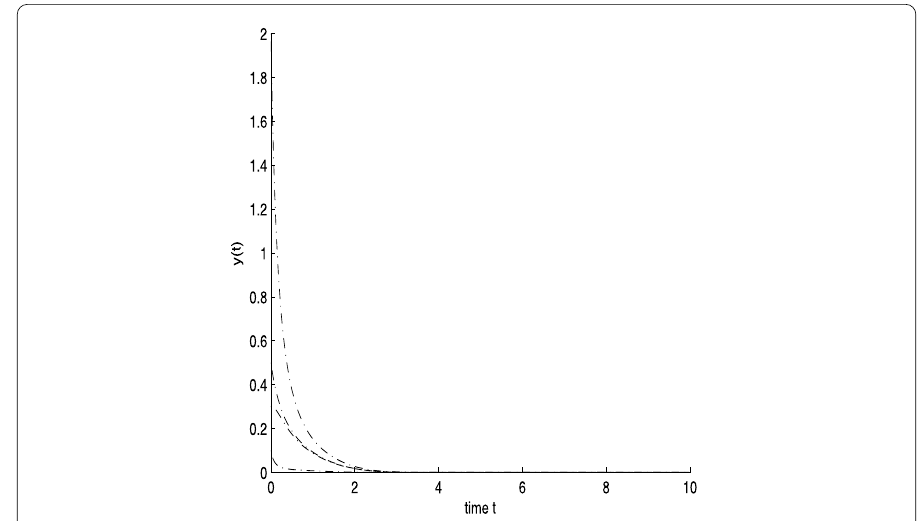
Figure 3 The extinction of the predator population of the system (5.2), with the initial condition condition ( x (0), y (0)) = (6,2),(2,0.5),(0.5,0.1) and (4,0.3),